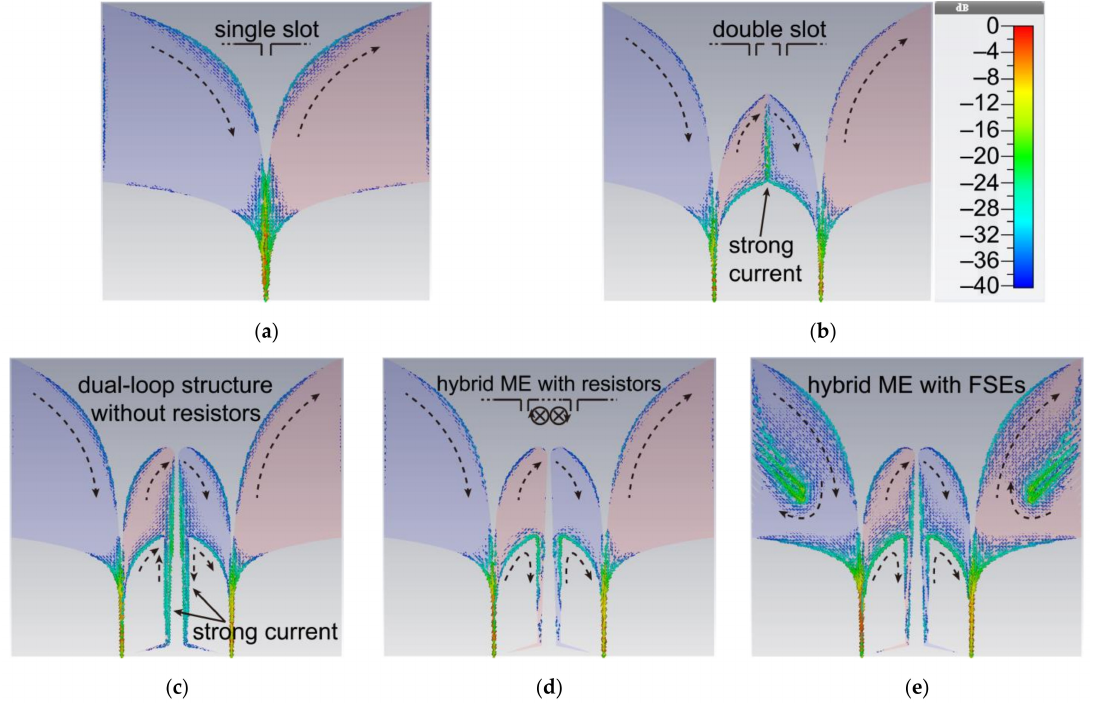
Figure 2. The surface current of ATSAs at 1 GHz and design evolution of radiating structure with the red part as the top metal layer, the blue part as the bottom metal layer, and the light gray part as the substrate. ( a ) The conventional ATSA; ( b ) the conventional DSATSA; ( c ) the dual-loop DSATSA without resistors; ( d ) the dual-loop DSATSA; ( e ) the dual-loop DSATSA with